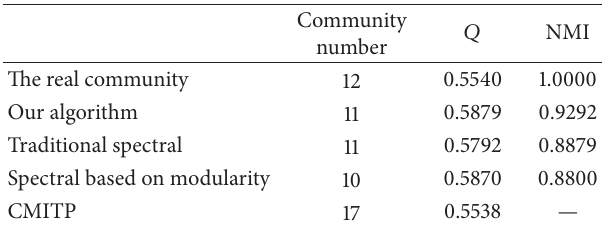
Table 3: The community number, 𝑄 and NMI of four